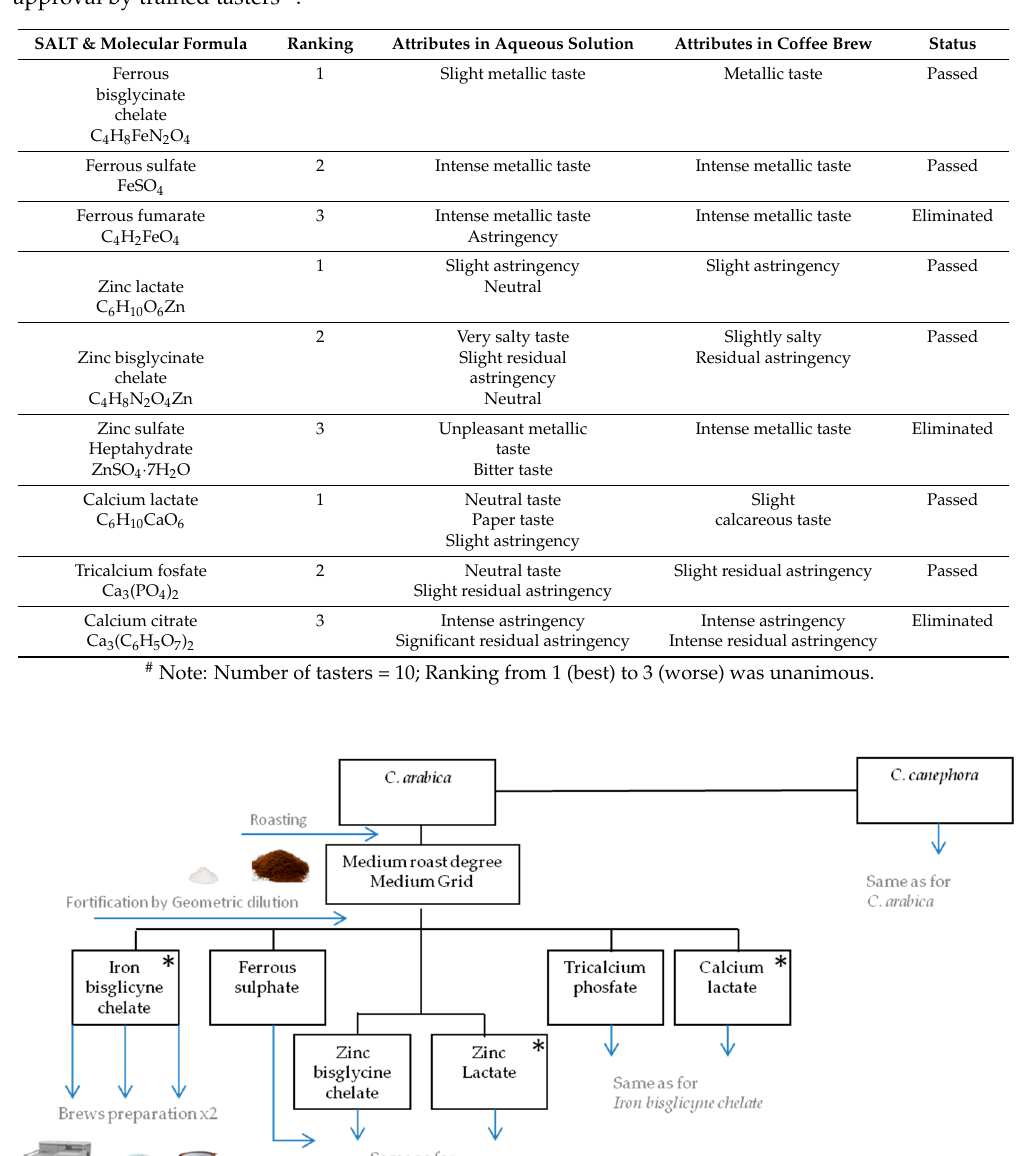
Table 1. Ranking and taste attributes described in preliminary screening evaluating mineral salts approval by trained tasters # .